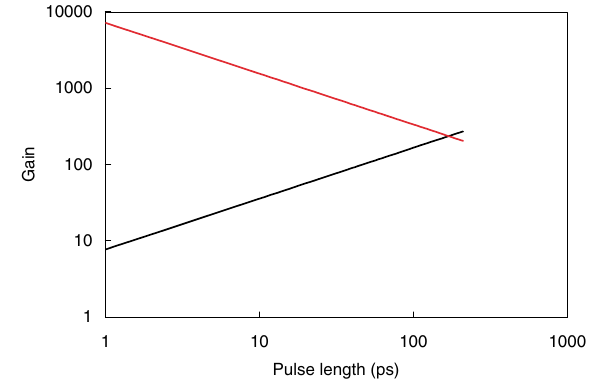
FIG. 5. (Color) Gain versus pulse length for constant pulse energy (500 J). The gain for an emittance-dominated electron beam is indicated by the black (lower) line, and that for a space-charge-dominated beam by the red (upper) line. The curves terminate at the quantum